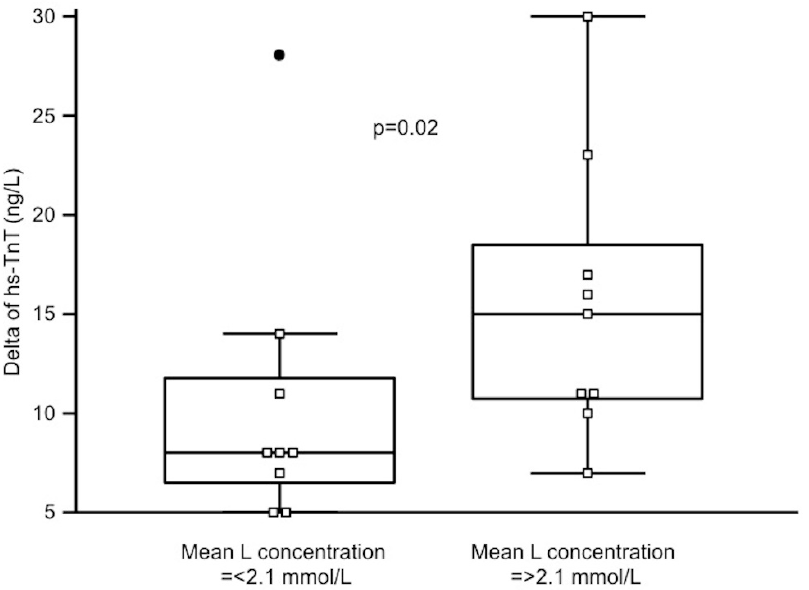
Figure 2. Example of lactate and glucose fluctuations during the race and running pace in one of the runners. L—lactate, Glu- glucose.